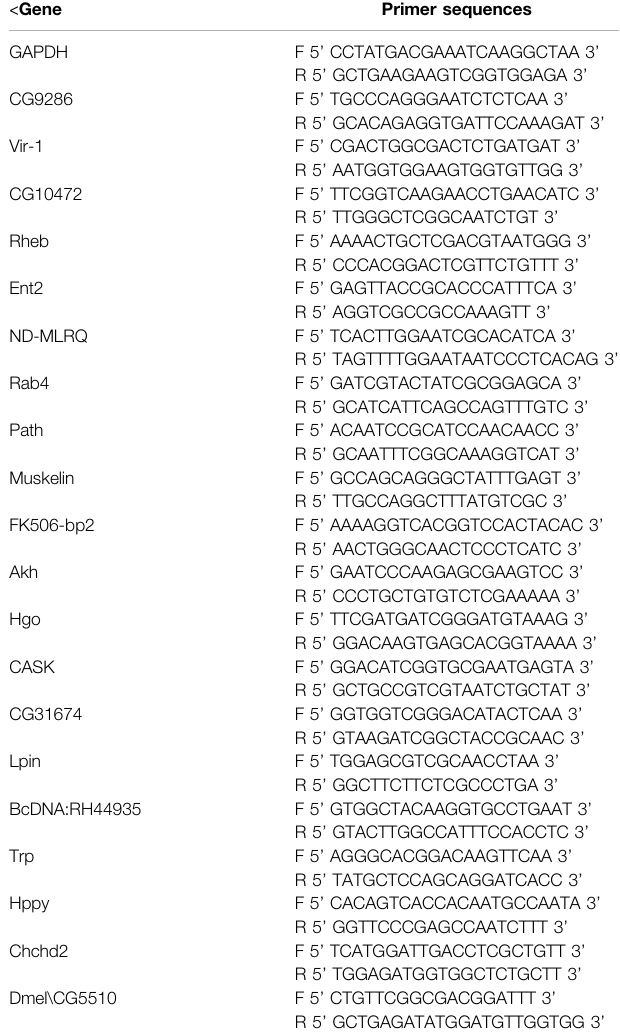
TABLE 1 | Primer sequences. < Gene Primer